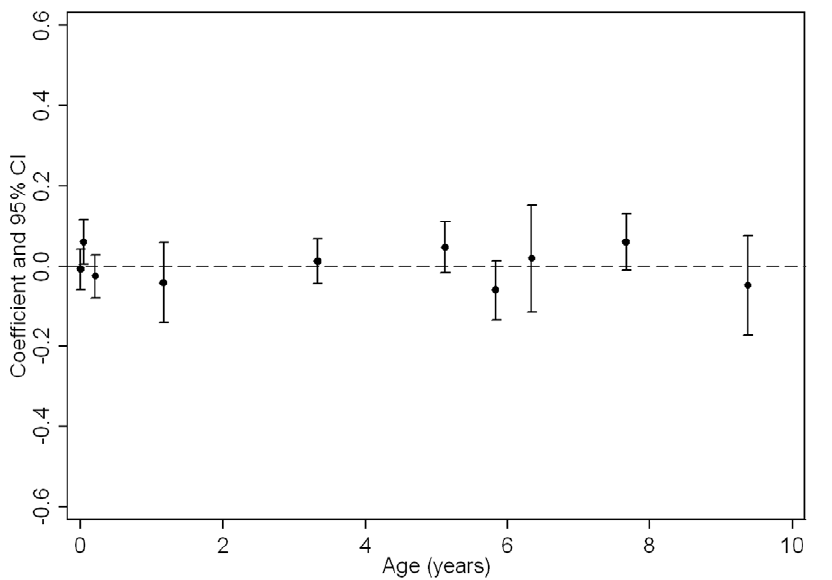
Figure 6. Girls Coefficients and 95% confidence intervals from standardised linear regressions of log triglycerides at age 15 on PI/ BMI trajectories (age in years along x-axis is the mid-point of PI/BMI change periods; coefficients are adjusted for confounders and previous PI/BMI changes, i.e. Model 3 in Tables).